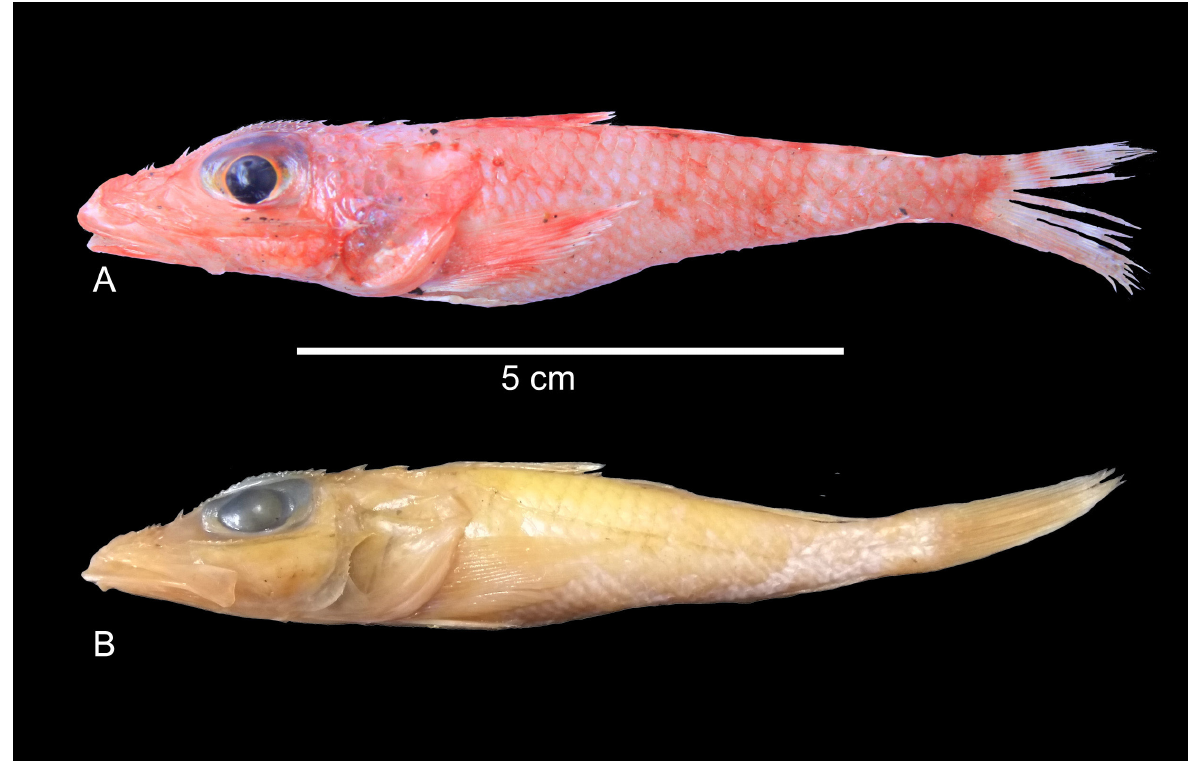
Fig. 1. Lateral view of Bembradium magnoculum Kishimoto, Kawai, Tashiro et Aungtonya, 2019 (CMLRE/349/04) from Car Nicobar Island north (362 m) ( A is the fresh colouration, B is colouration after preservation in